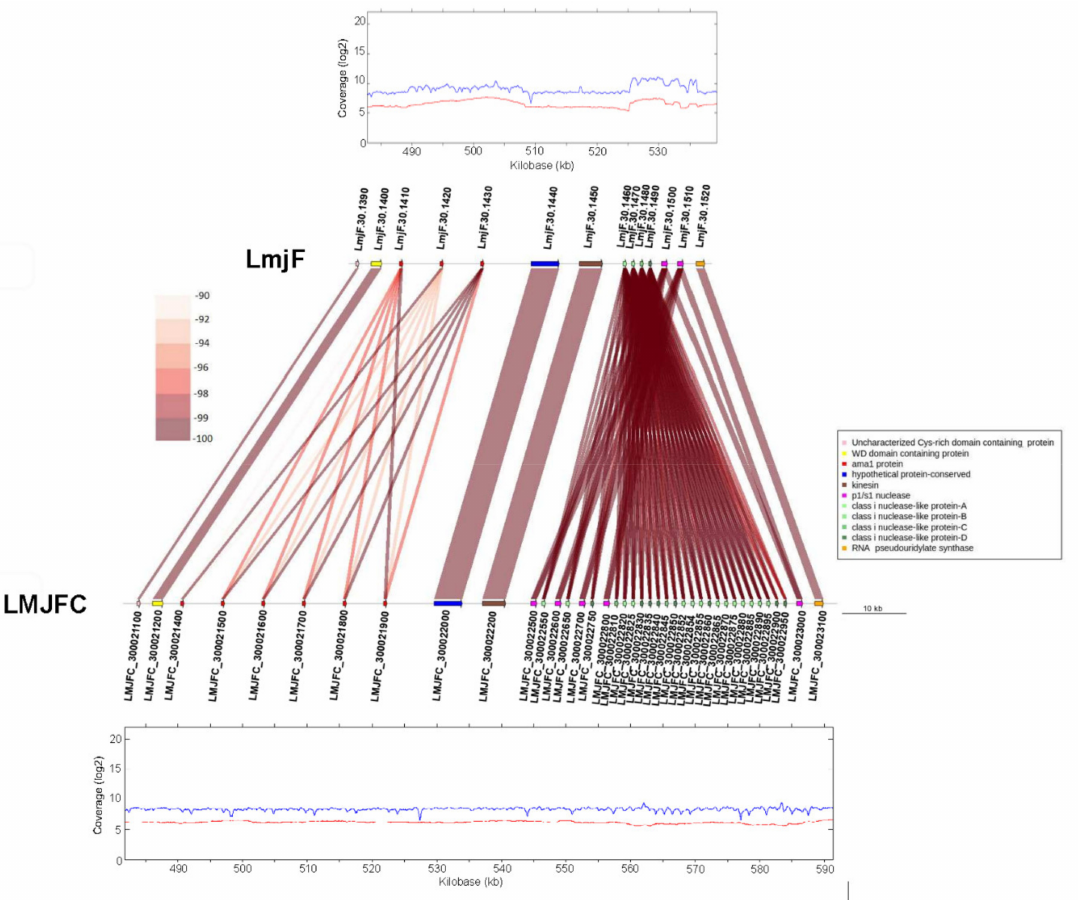
Figure 4. Different gene copy numbers exist in a central region of chromosome 30 in the LmjF and LMJFC assemblies. Gene sequence identity is shown according to a color-intensity scale. The upper and bottom graphs show the cover- ages of Illumina reads (in blue) and PacBio reads (in red) mapped to this chromosomal region in the LmjF and LMJFC assemblies,